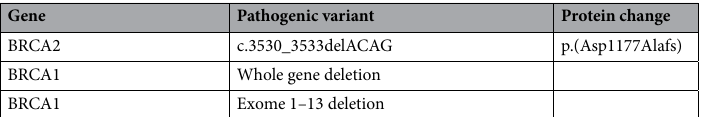
Table 11. The pathogenic BRCA1 and BRCA2 variants in southwestern Finland, which are very rare in other parts of Finland and are rare also in southwestern Finland.